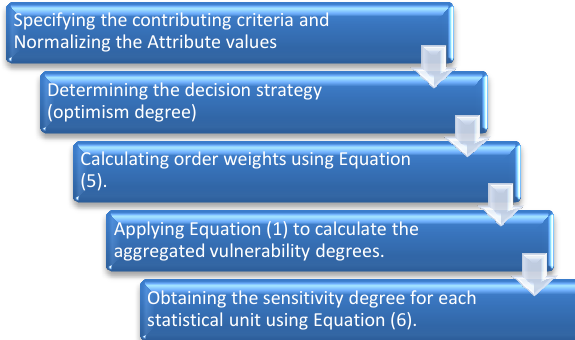
Figure 1. Steps to analyze the sensitivity of model